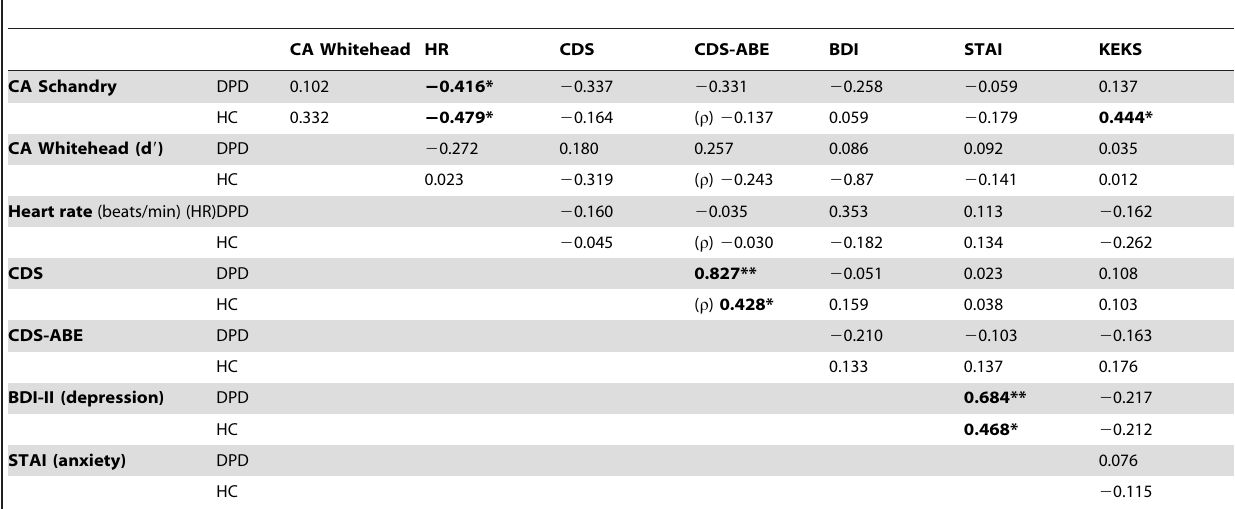
Table 4. Correlation coefficients of heartbeat detection measures and heart rate with psychometric scores: DPD patients white row and healthy controls (HC) grey